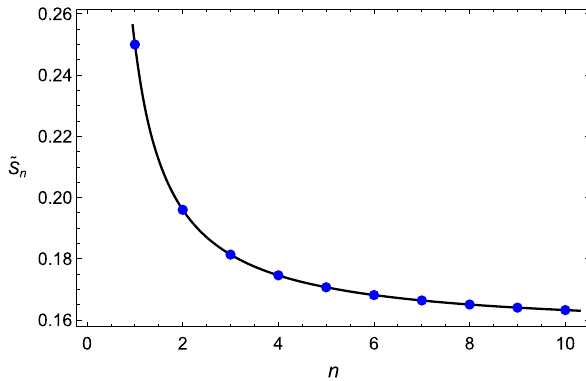
Fig. 1 The Rényi entropies computed from the hyperbolic black hole